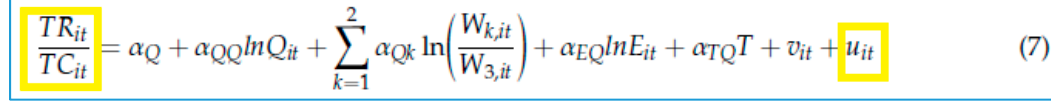
Figure 2. KL’s basic equation in the Lerner index calculation process.